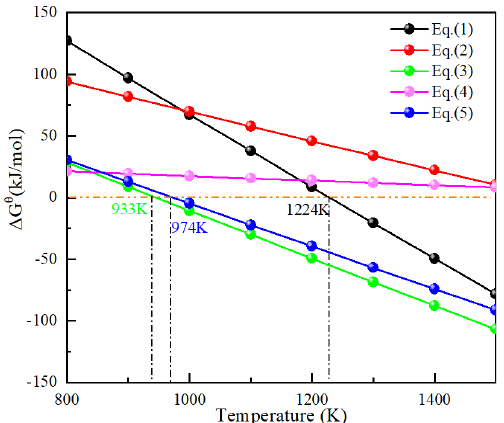
Figure 2. Relationship between the standard Gibbs free energy and temperature for Equations (1)–(5).